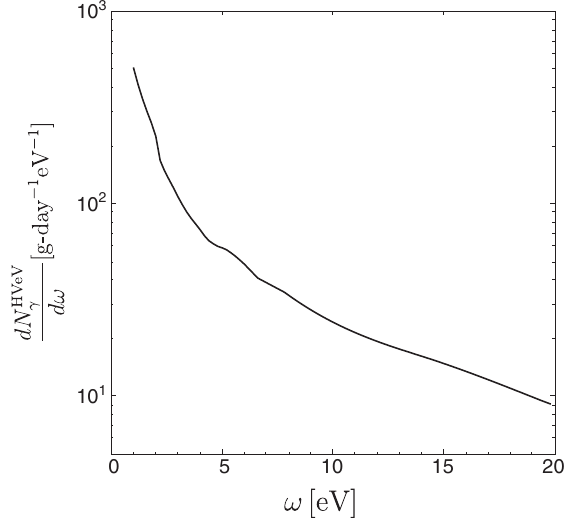
FIG. 21. The estimated number of photons (per g-day expo- sure) created in transition radiation from charged particles passing the interface between the copper vessel and vacuum at the SuperCDMS HVeV detector, dN HVeV γ =d ω , as a function of the emitted photon energy ω